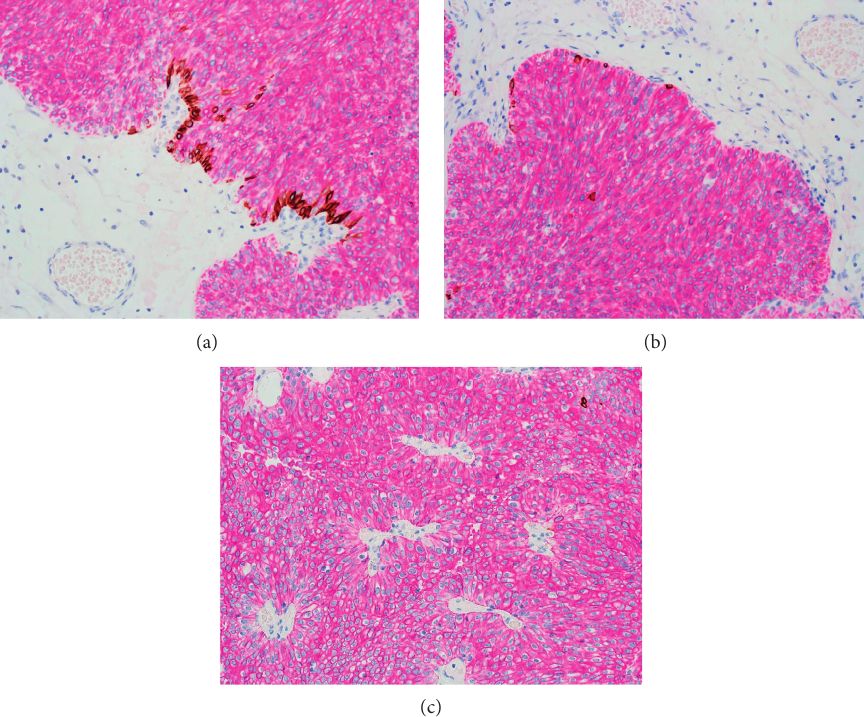
Figure 4: (a) High-grade urothelial carcinoma with partial loss of basal cells but diffuse staining for CK20. (b) High-grade urothelial carcinoma with almost complete loss of basal cells. (c) High-grade papillary urothelial carcinoma revealing diffuse immunohistochemical staining for CK20 and complete absence of basal layer with no staining for